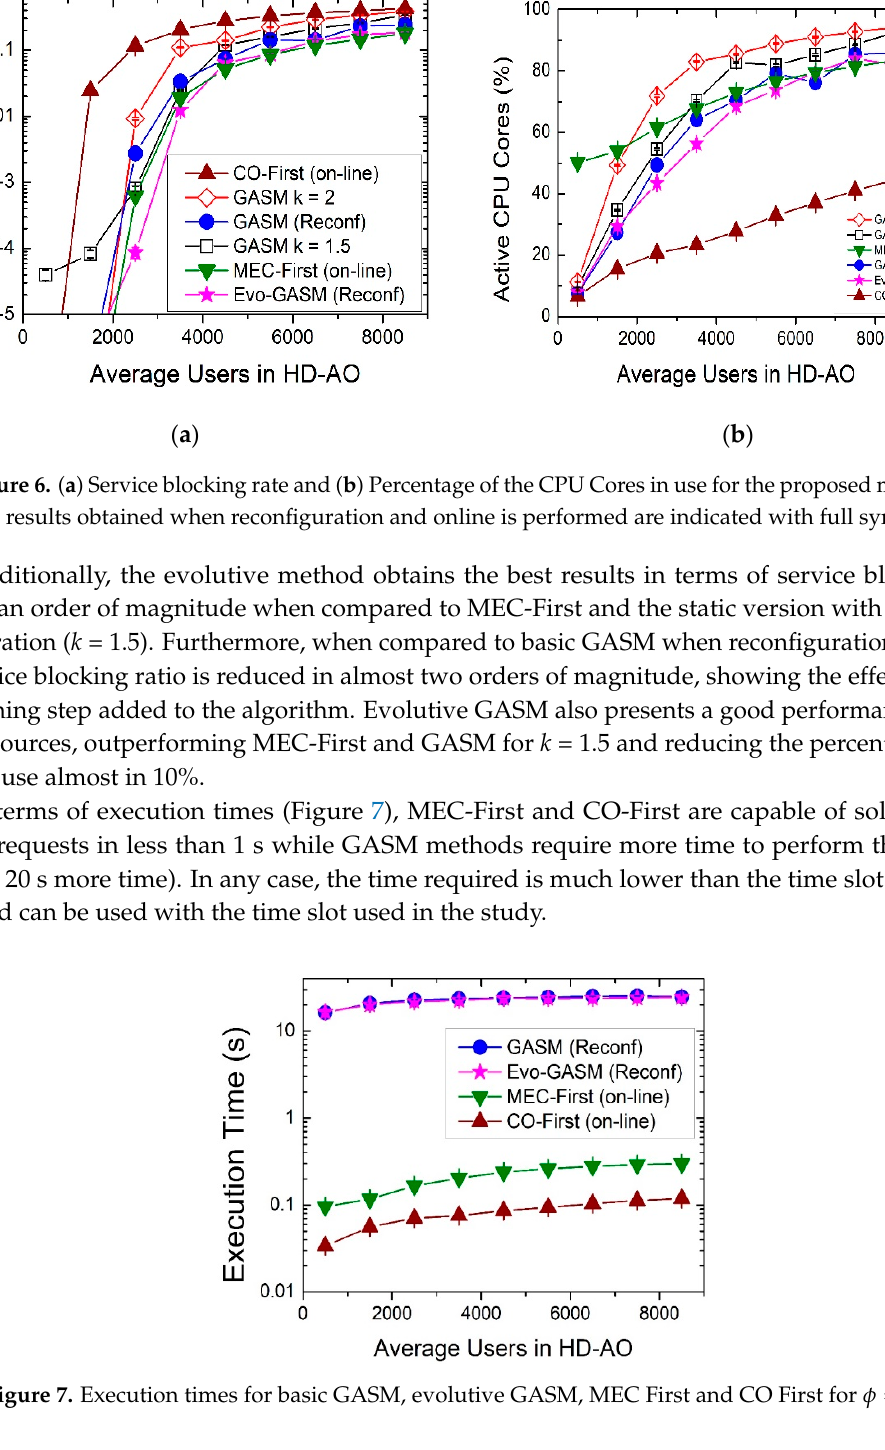
Figure 6. ( a ) Service blocking rate and ( b ) Percentage of the CPU Cores in use for the proposed methods. The results obtained when reconfiguration and online is performed are indicated with full symbols.